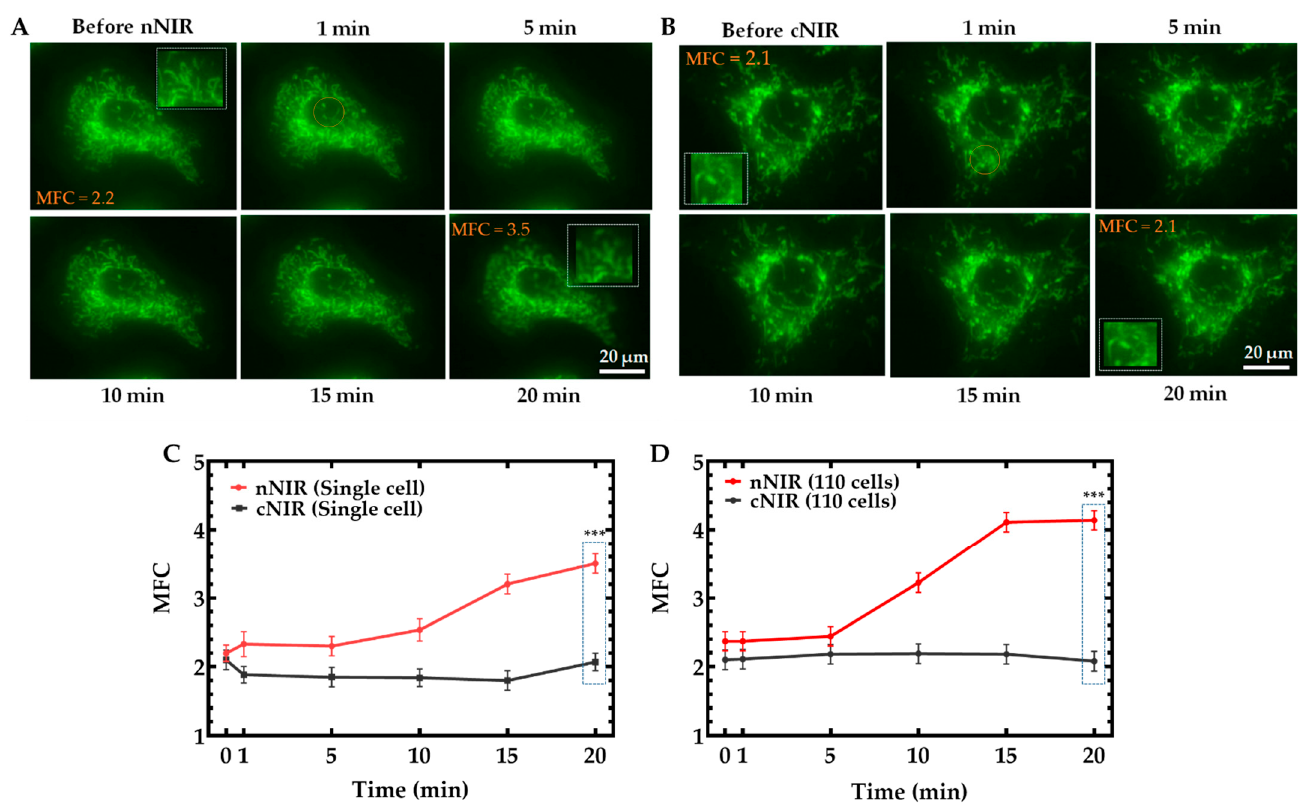
Figure 4. A549 cells ( n = 50) exposed to 224.02 J/cm 2 nNIR and cNIR for 10 s and imaged in a time- dependent manner at 0, 1, 5, 10, 15, and 20 min. ( A ) Mitochondrial dynamics of a single cell exposed to 224.02 J/cm 2 nNIR showed significant mitochondrial structural fragmentation. ( B ) Mitochondrial dynamics of a single cell cytosol exposure to 224.02 J/cm 2 cNIR, and an image analysis showed no significant impact on mitochondrial dynamics. ( C ) The MFC of a single A549 cell exposed to ( A ) nNIR and ( B ) cNIR showed a very significant (*** p < 0.01) increase in MFC of nNIR compared to cNIR (MFC: 3.50 ± 0.2 nNIR; *** p < 0.01 vs. 2.1 ± 0.2 cNIR). ( D ) An average of 110 single cells exposed